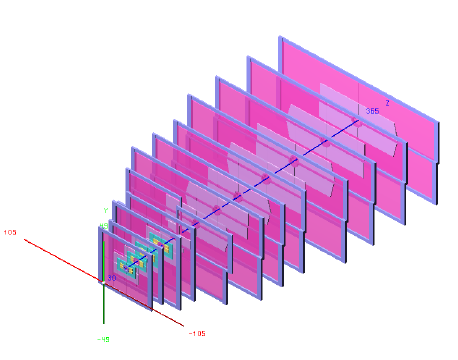
Figure 1. BM@N GEM tracker: full configuration.